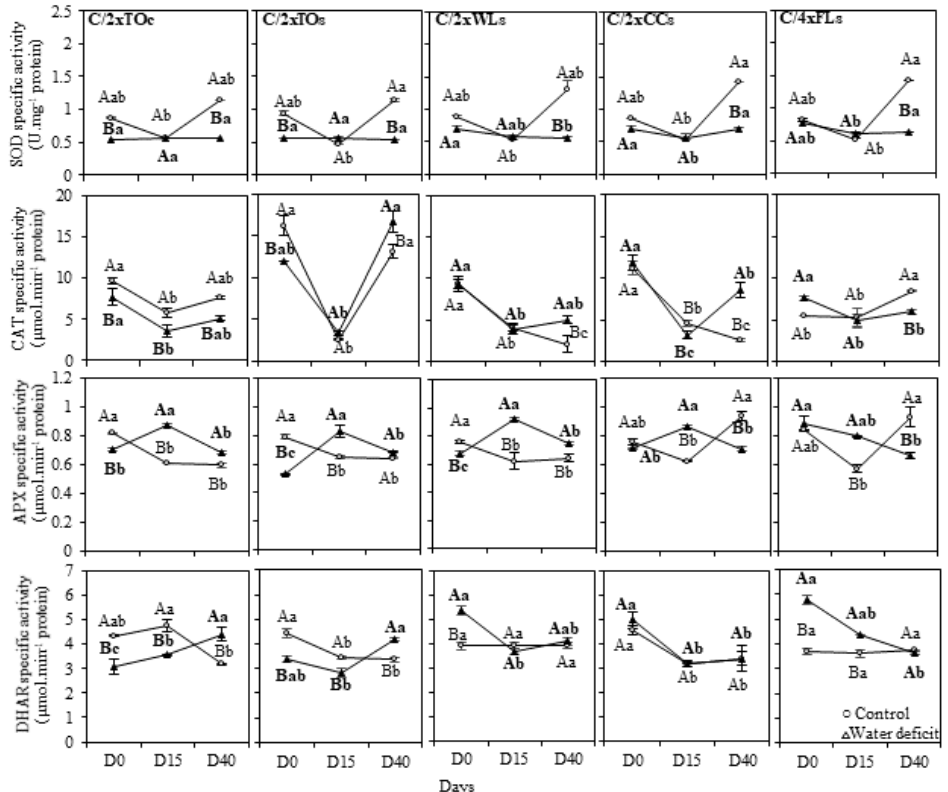
Figure 4. Influence of water deficit on antioxidant enzyme specific activities of superoxide dismutase (SOD), catalase (CAT), ascorbate peroxidase (APX) and dehydroascorbate reductase (DHAR) of clementine trees grafted onto different rootstocks. The tested diploid rootstocks grafted with common clementine were trifoliate orange cutting (C/2xTOc), trifoliate orange seedling (C/2xTOs), Carrizo citrange (C/2xCCs) and Willowleaf mandarin (C/2xWLs) and FlhorAG1, an allotetraploid somatic hybrid (C/4xFLs). The white circles and the black triangles correspond to the values obtained under control and water deficit, respectively. All specific activities were measured on leaves after different period: day 0 (D0) (control), day 15 (D15) and day 40 (D40) after the beginning of the experiment. All